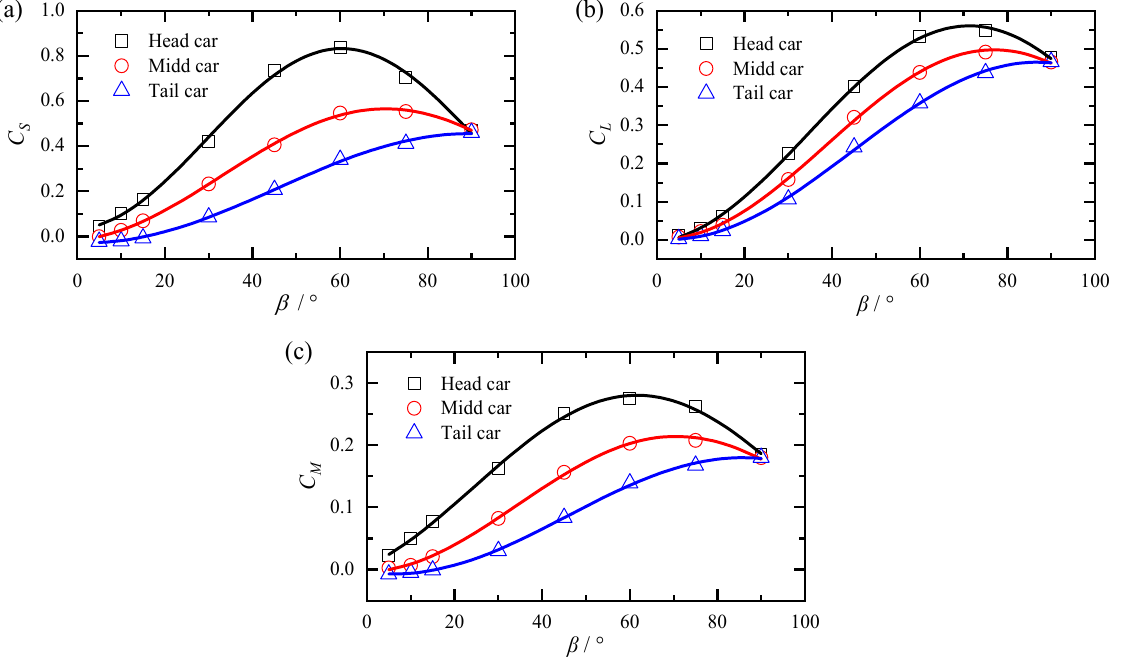
Figure 11. Aerodynamic coefficients of the train at various resultant wind angles: ( a ) side coefficient; ( b ) lift coefficient; ( c ) Rolling coefficient.